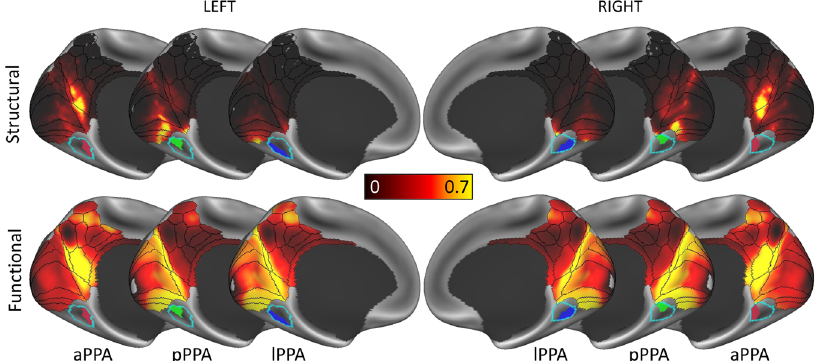
Fig. 3 PPA clusters share similar structural and functional connectivity pro fi les. Structural and functional connectivity of the three parahippocampal place area (PPA) clusters. The anterior cluster (aPPA) is preferentially connected to retrosplenial complex and corresponds to the parieto-medial-temporal branch of the dorsal visual stream 21 . The posterior cluster (pPPA) is preferentially connected to the anterior medial occipital lobe, i.e., peripheral representations within early visual cortex (EVC). The lateral cluster (lPPA) is more ambiguous but is preferentially connected to EVC. This is discussed in detail in Supplementary Note 1 (also see Supplementary Figs. 1 –